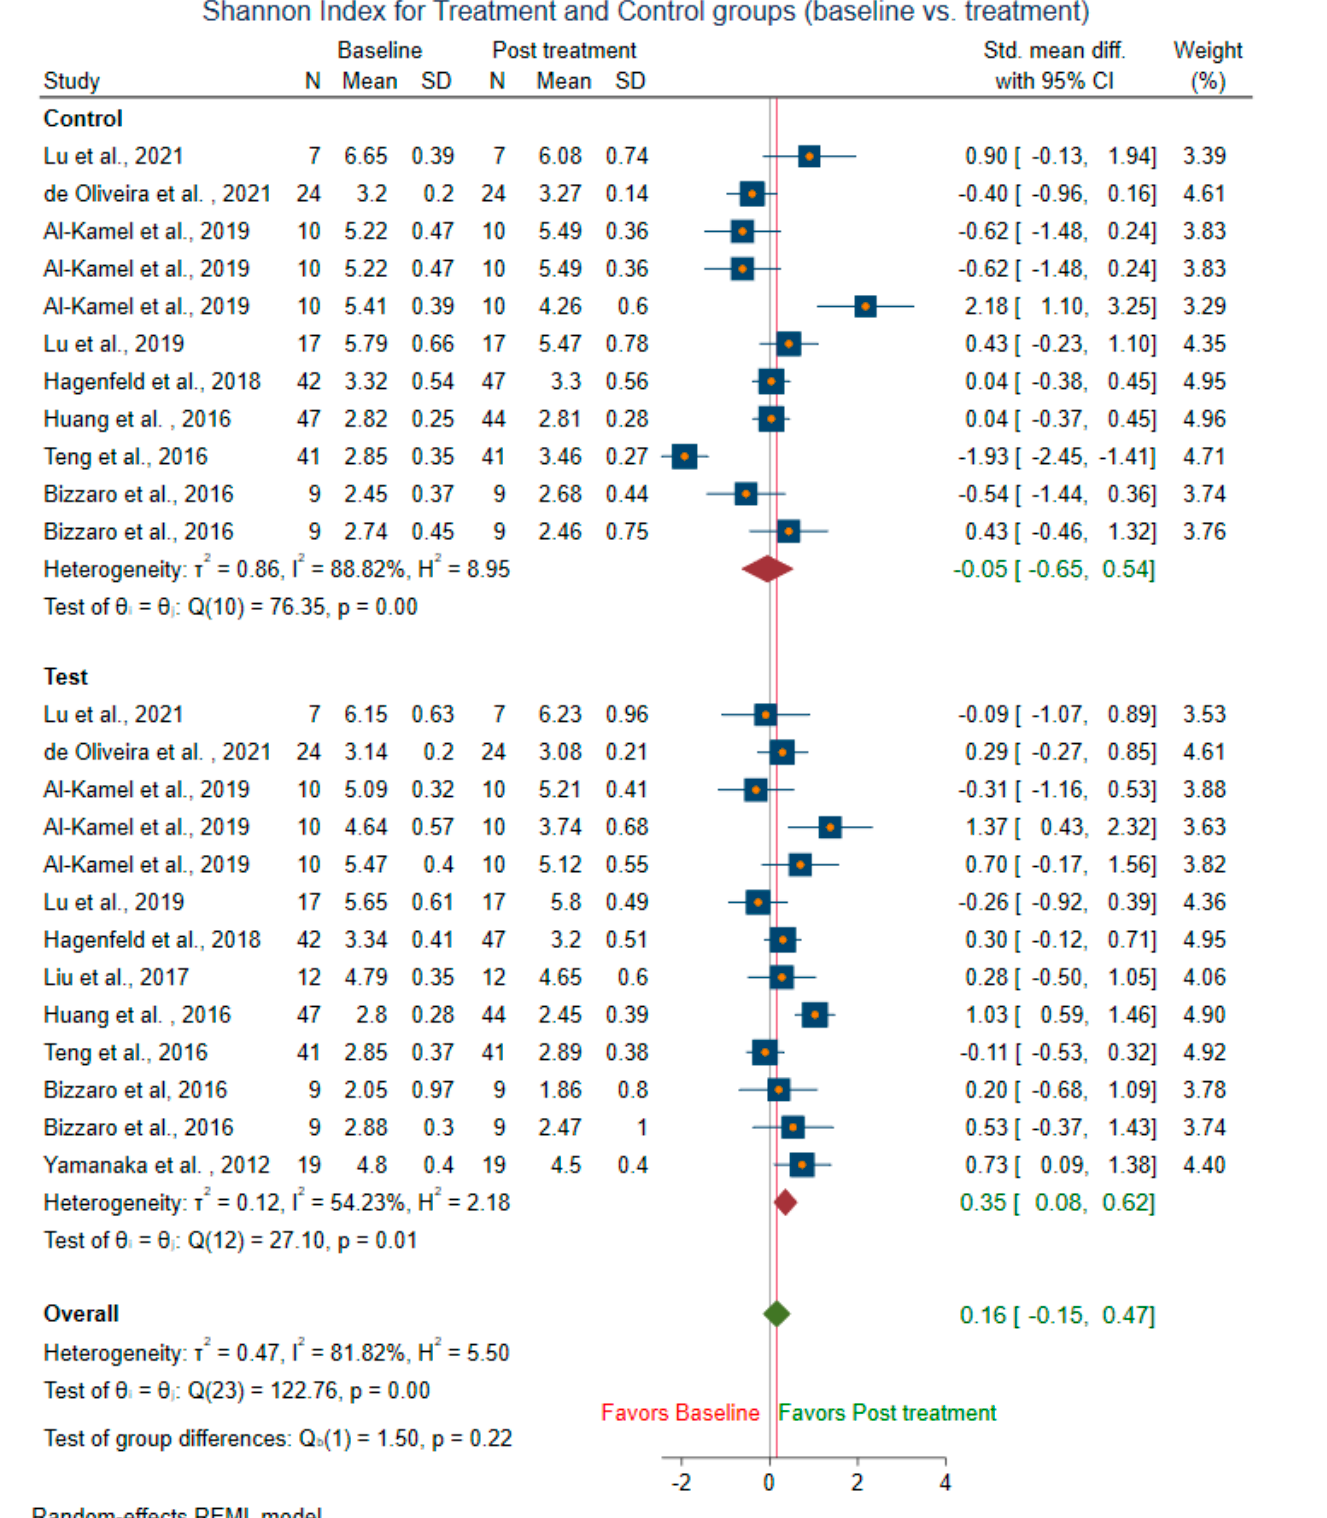
Figure 5. Subgroup meta-analysis of Shannon index based on test subgroup (baseline vs. post- treatment) and control subgroup (baseline vs. post-treatment).